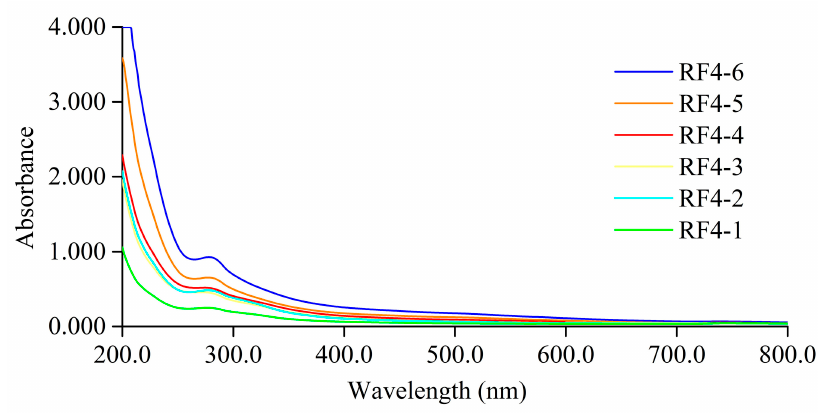
Figure 6. UV-VIS spectrum of different MW fractions obtained from RF4 by ultrafiltration. The aqueous solutions of fractions were 0.2 mg/mL.